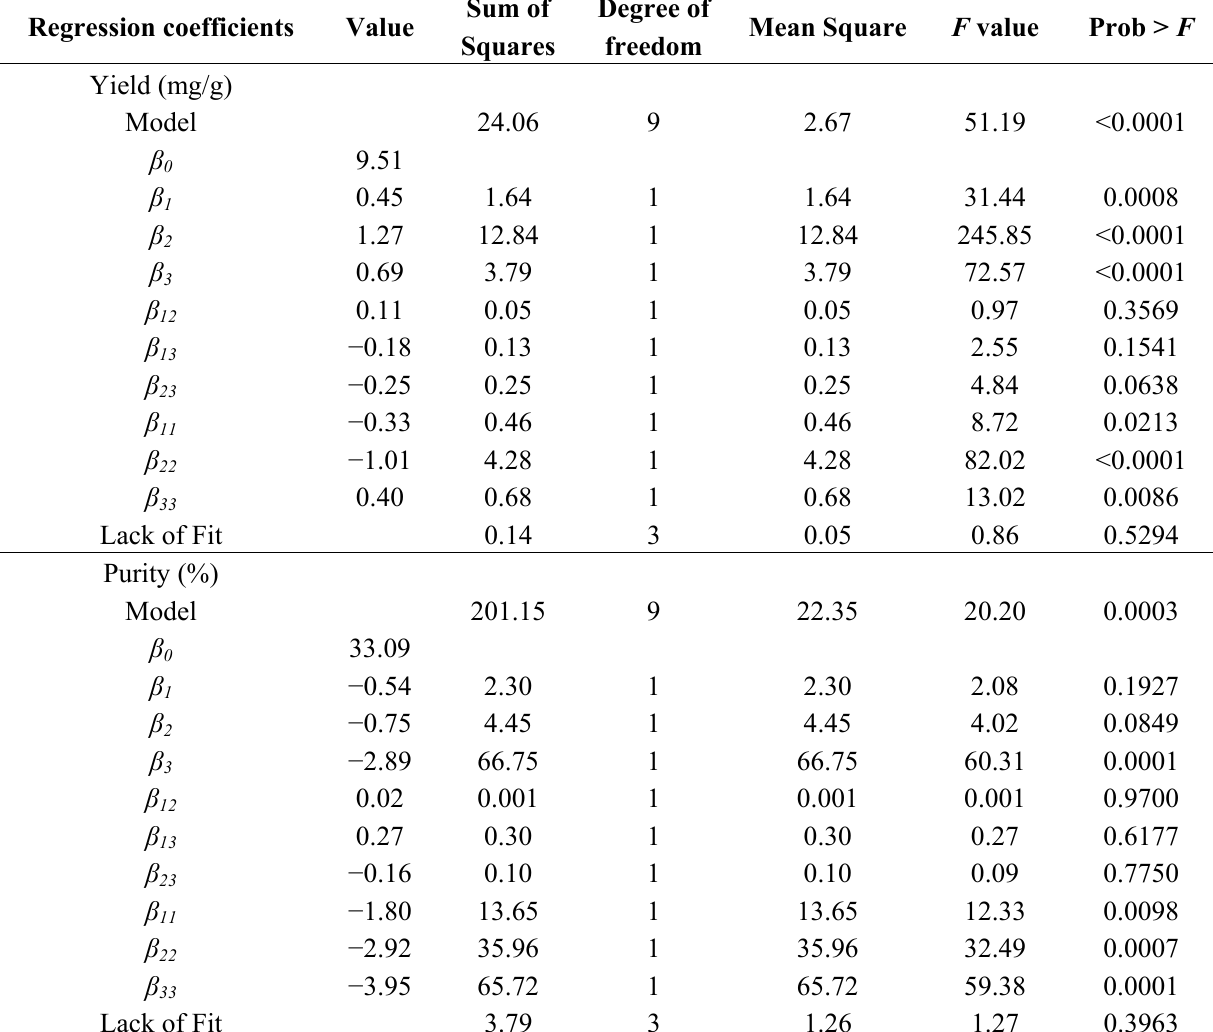
Table 2. Estimated regression coefficients for the quadratic polynomial model and ANOVA for the experimental results in the optimization of shikonin